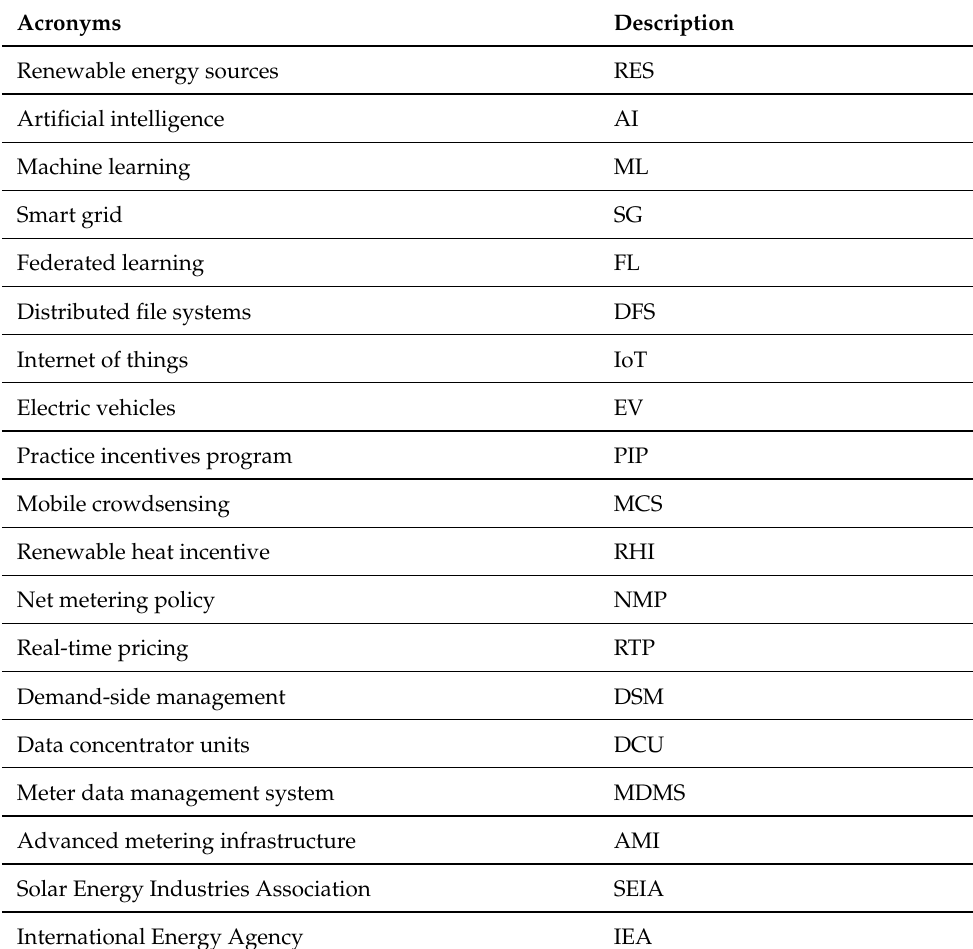
Table 2. Key (repeated)